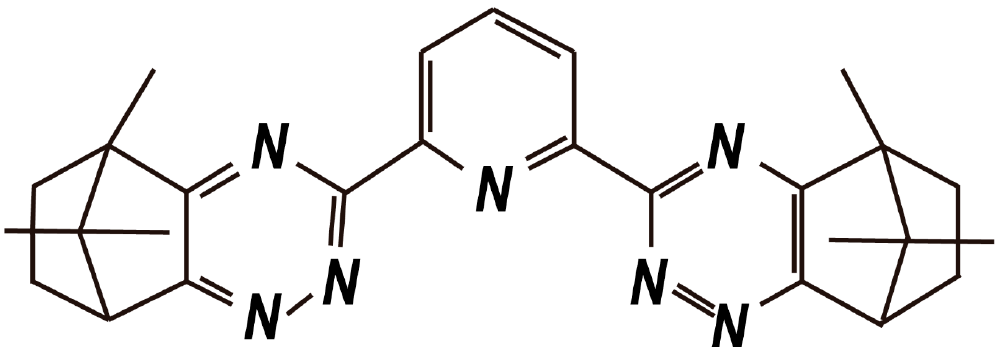
Figure 16. Chemical structure of CA-BTP (bis-2,6-(5,6,7,8-tetrahydro-5,9,9-trimethyl-5,8-methano